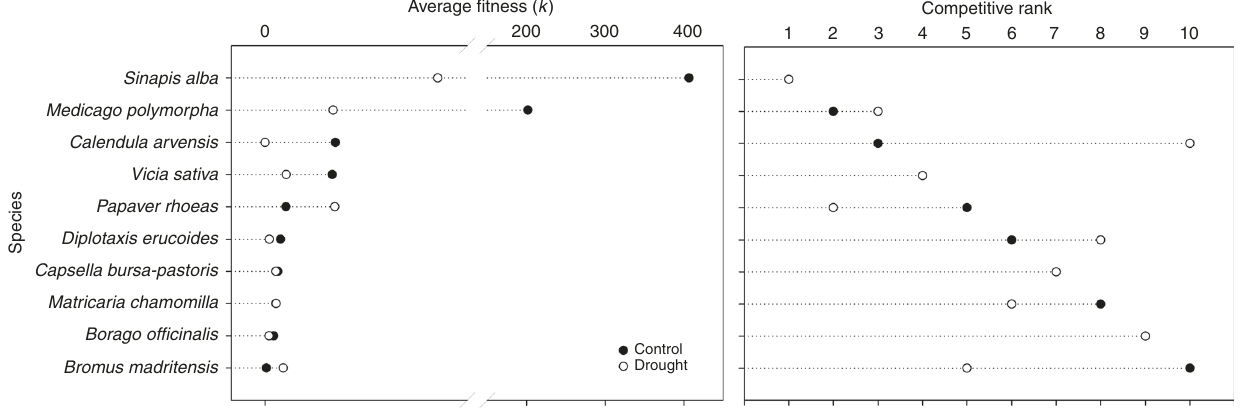
Fig. 2 Estimates of species ’ average fi tness and competitive ability for the two climatic conditions. Species ’ average fi tness (left side) were obtained from experimentally derived species vital rates and competitive coef fi cients using Eq. (3).). Average fi tness in the absence of niche differences served to rank species according to their competitive ability (right side). Black circles correspond to the control treatment and white circles to drought. The competitive rank panel serves to observe competitive trade-off between climatic treatments as species did not perform equally in both treatments. Some clear examples are Calendula arvensis and Bromus madritensis . In the competitive rank panel, only white circles are shown in those species that attained the